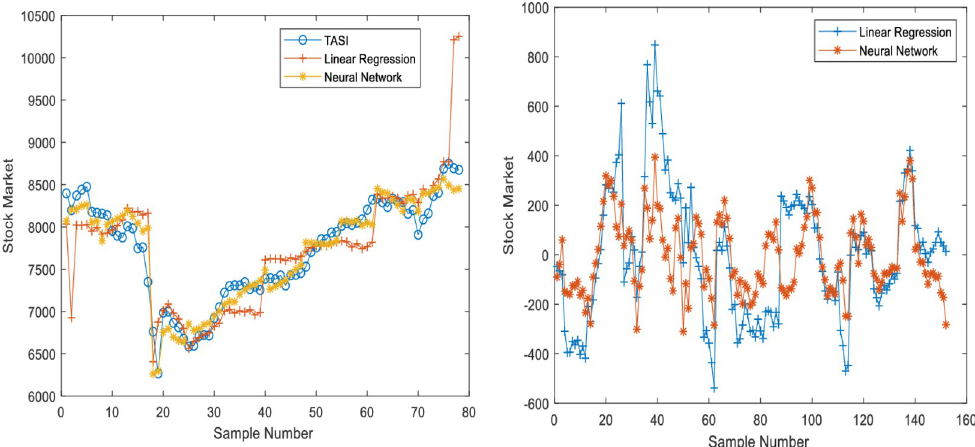
Fig 3. Performance analysis of testing datasets using (a) predicted values and (b) Error functions based on neural network and linear regression.